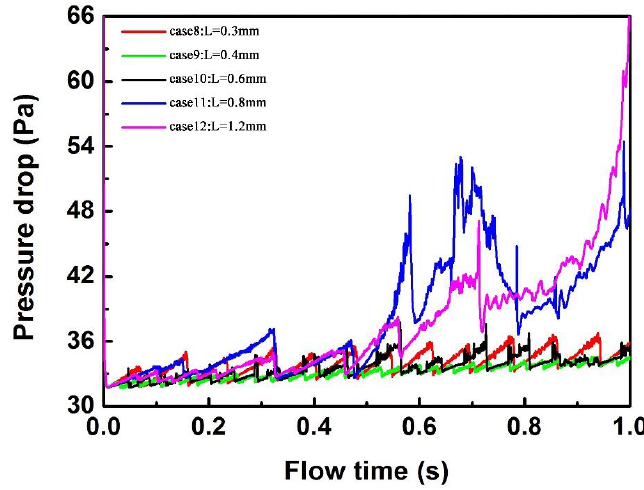
Figure 11. Effect of the pore distance on the pressure drop between the inlet and outlet of the channel.